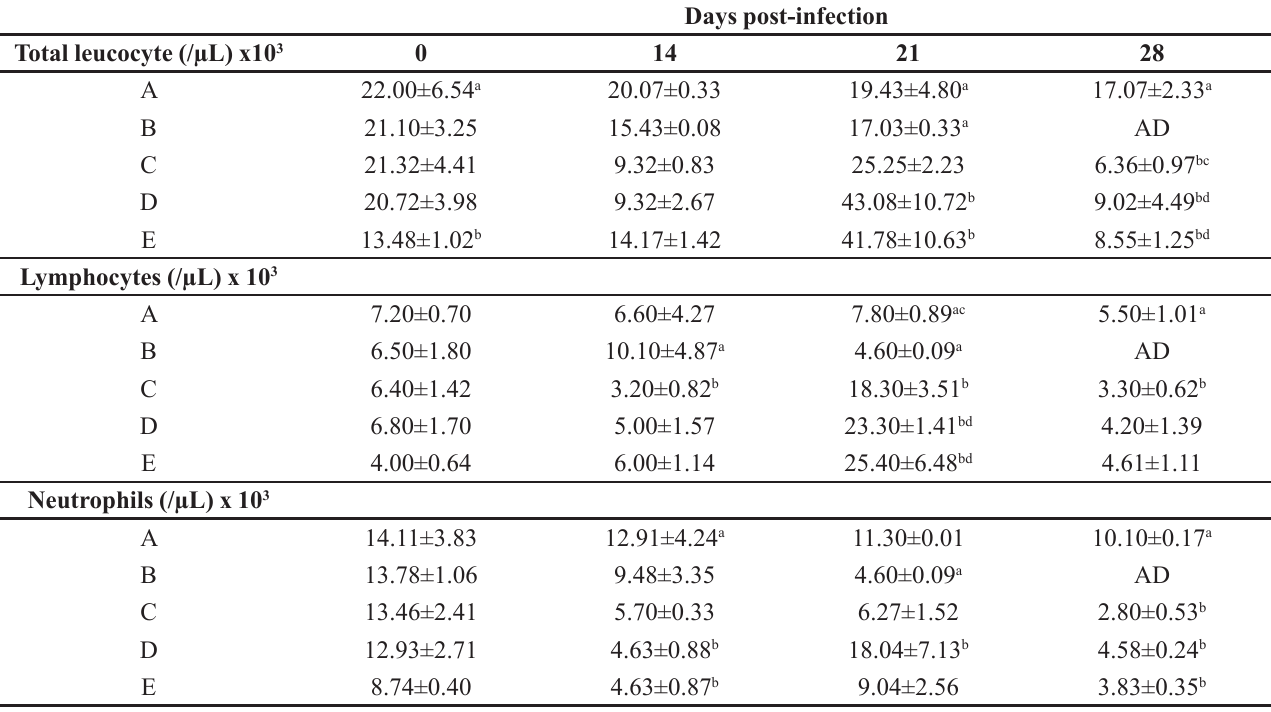
TABLE I - Mean total leucocyte, lymphocyte and neutrophil counts in dogs infected with T. b. brucei and treated with combinations of SEC-DA and DA